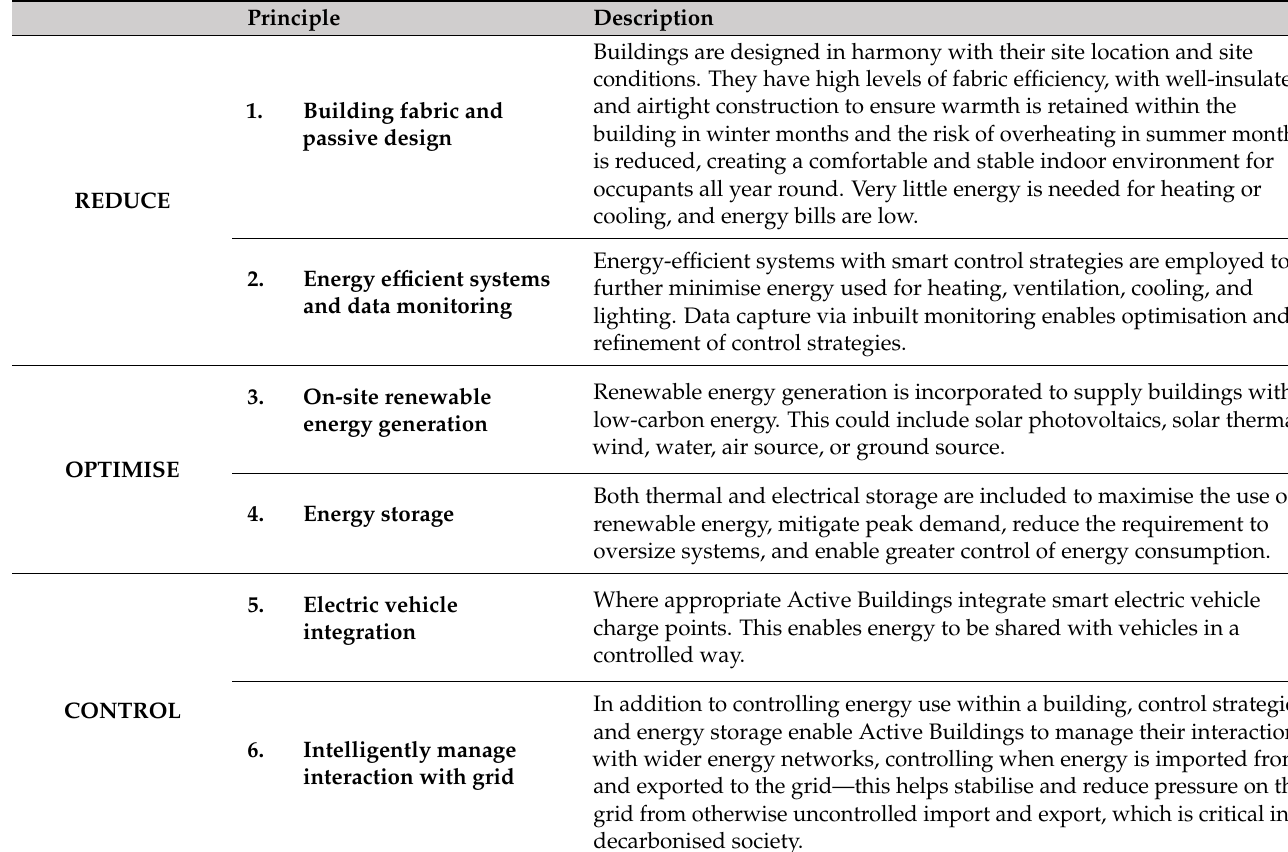
Table 1. The Active Building (AB) Principles